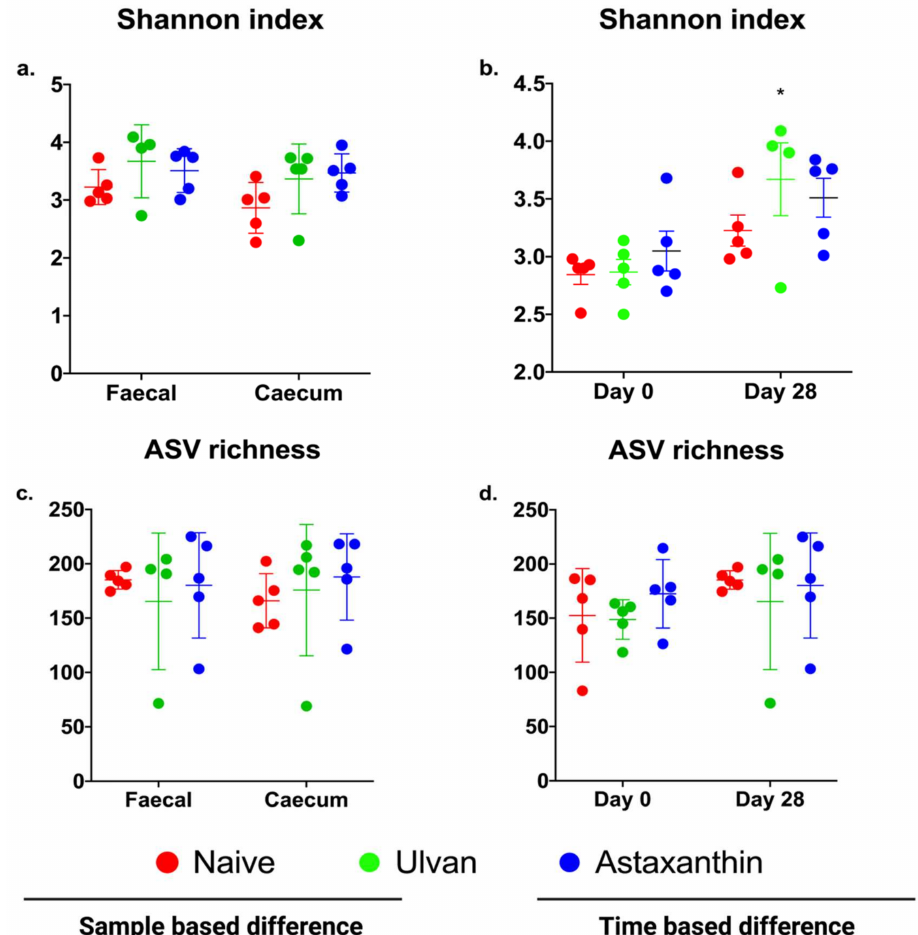
Figure 2. Differences in the diversity and richness between the fecal and caecum samples based on the type of sample and time (Day 0 and 28), as shown using the Shannon index and ASV richness. Shannon diversity index ( a , b ) and ASV richness ( c , d ) data based on sample and time difference are presented as mean ±